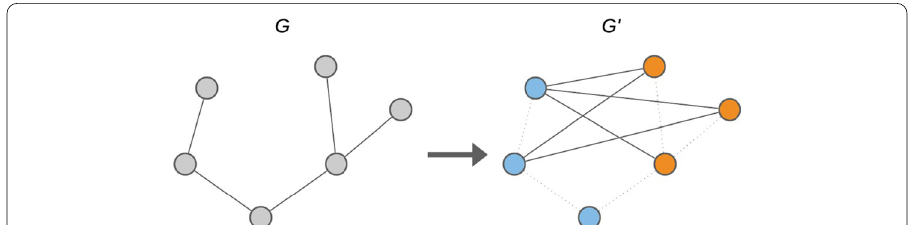
Fig. 2 An example of the auxiliary graph construction with l B = 2 . The nodes with the same color in G ′ form a box in